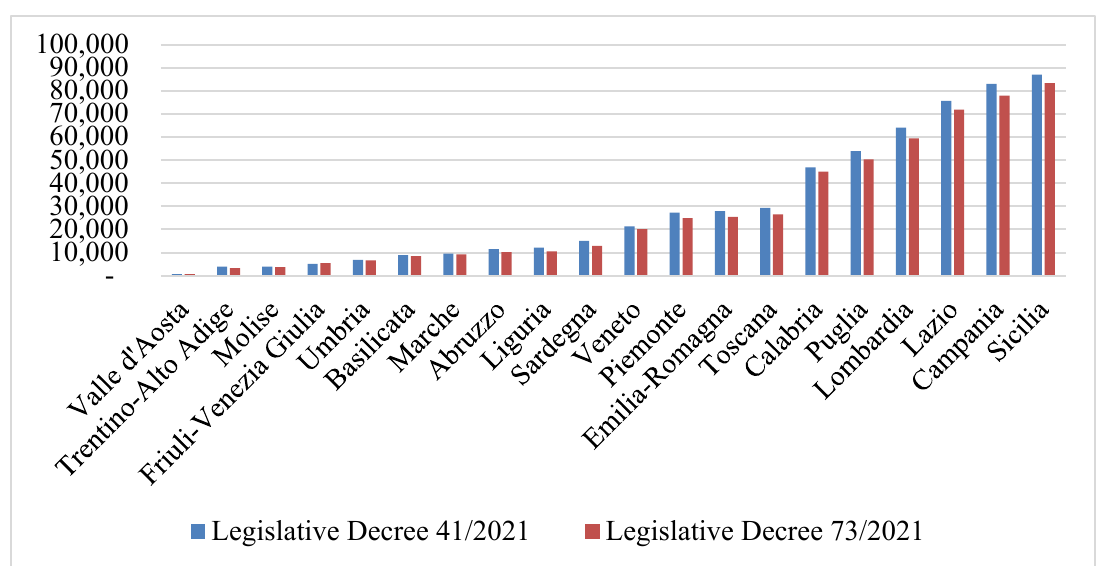
Figure 17. REM household recipients, by regions and Legislative Decree, 2021. Source: own elaboration on the INPS database.